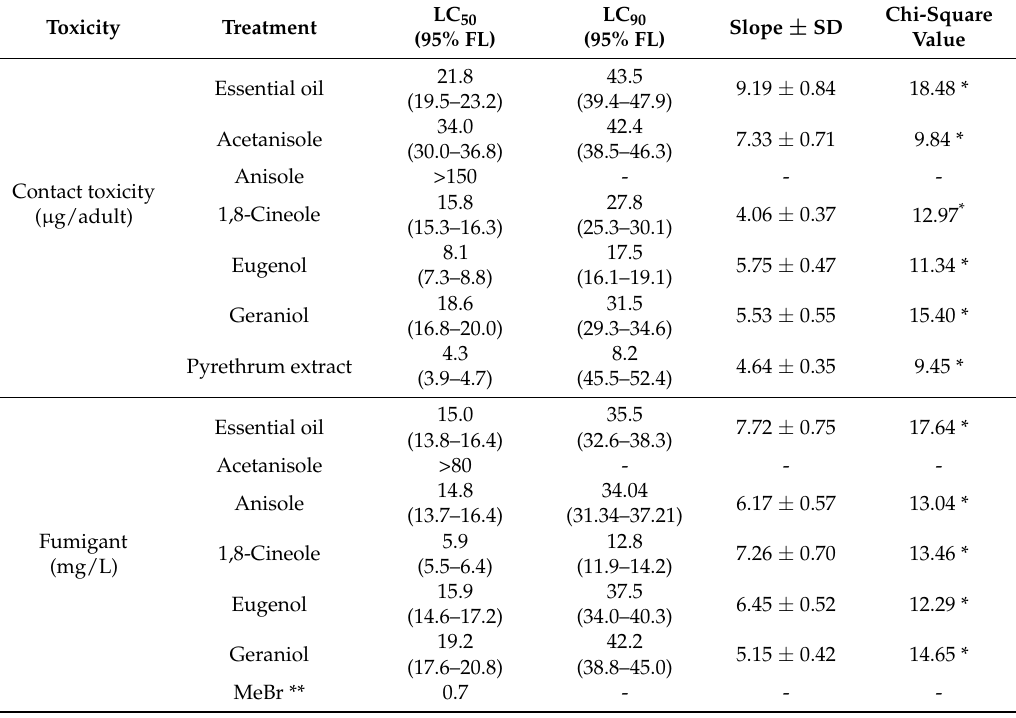
Table 3. Contact and fumigant toxicity of the essential oil of Stachys riederi var. japonica aerial parts against the adults of Sitophilus zeamais